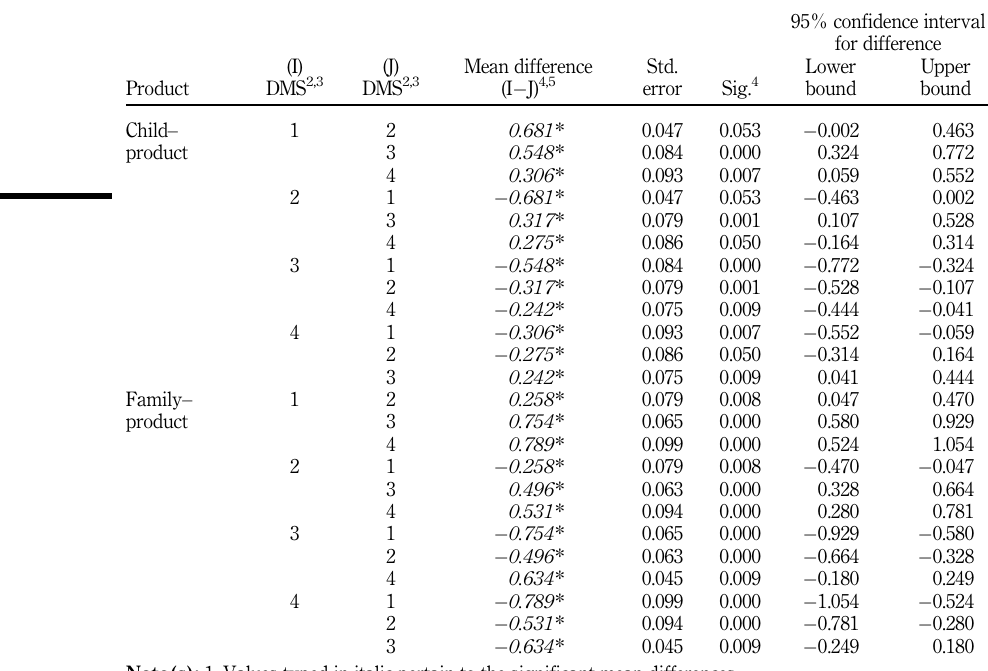
Table 4. Results relating to pairwise comparisons 1